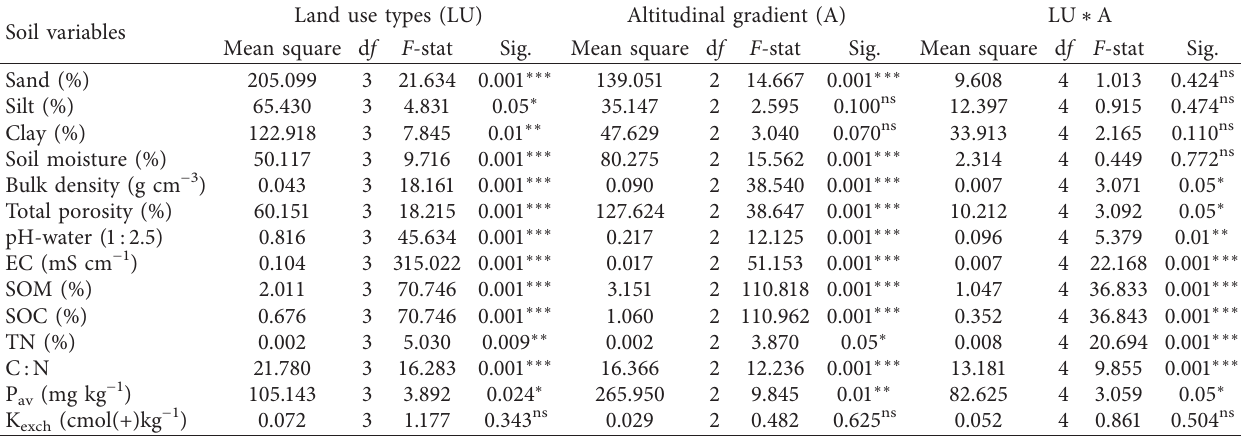
Table 2: Analysis of variance summary results for selected soil physicochemical properties in different land use types and altitudinal gradients.